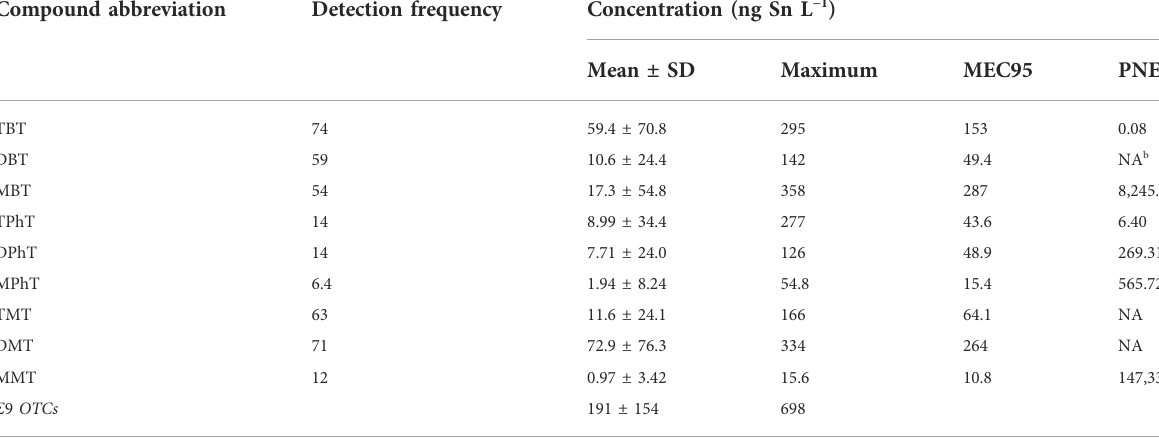
TABLE 1 Statistical summary of organotin compounds (OTCs), including mean, standard deviation (SD), maximum concentrations, 95th percentile of the measured environmental concentration (MEC 95 ), and the lowest value of predicted no-effect concentration in freshwater (PNEC fw ) in the drinking water source in the upper Yangtze River